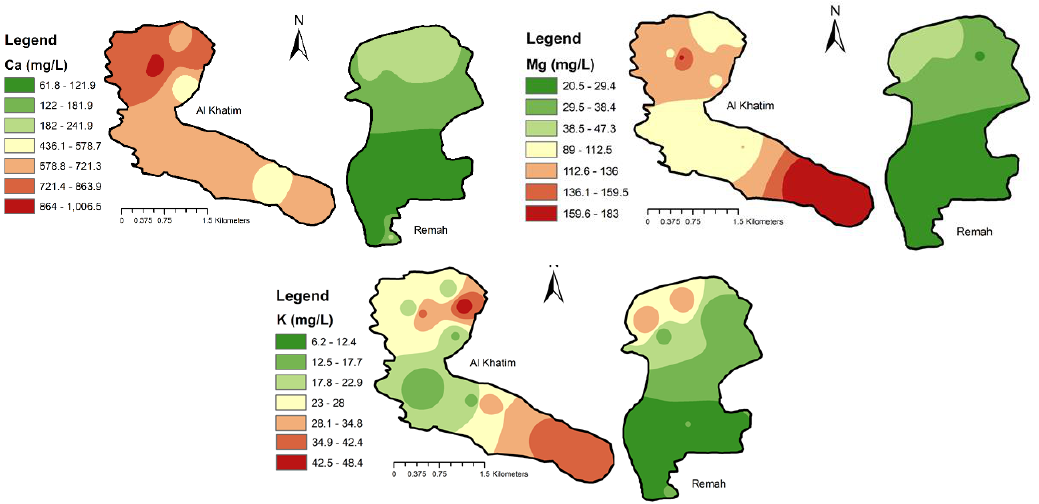
Figure 8. Spatial distribution of calcium (Ca 2+ ), magnesium (Mg 2+ ), and potassium (K + ) ions.